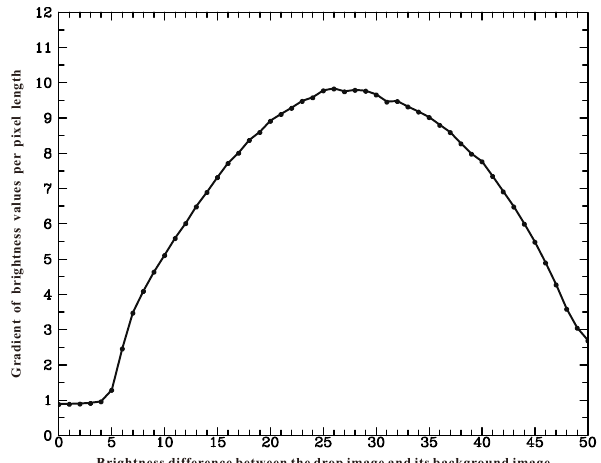
Figure 3. Statistical relationship between the gradient of brightness values per pixel length (ordinate) and the difference in the bright- ness values between the drop image and its corresponding back- ground image (abscissa) calculated from all recorded images of 95 water drops collected from the indoor experiment.